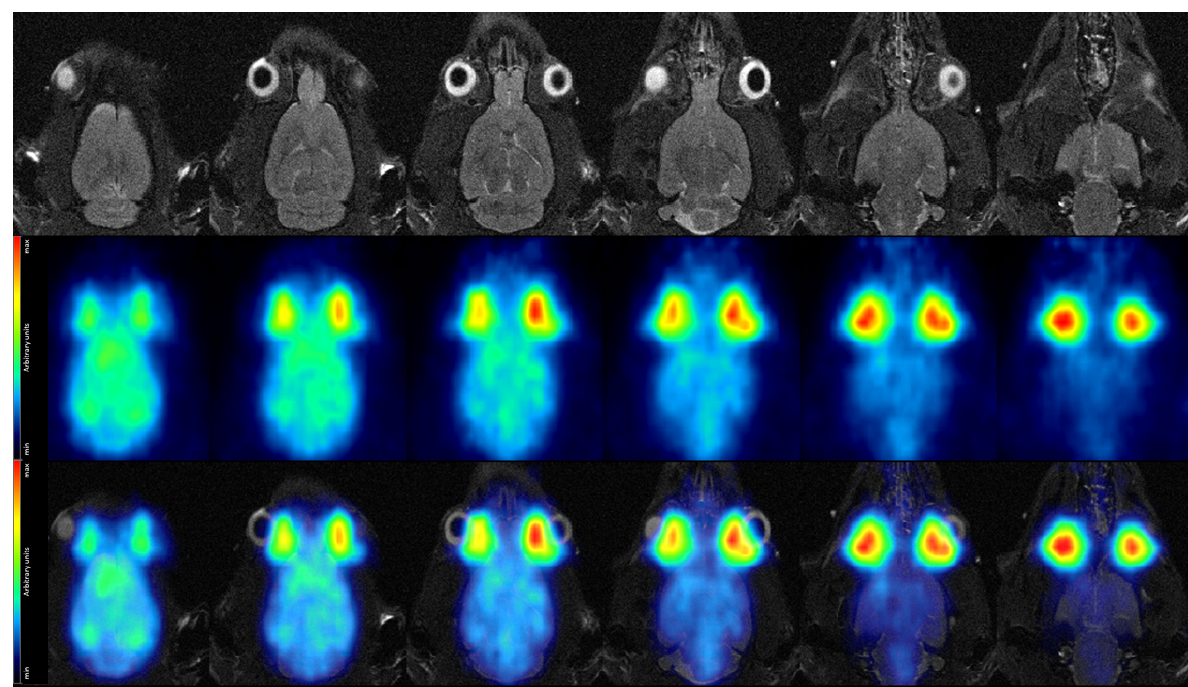
Figure 15. Coronal view of the rat brain in vivo. ( Top row ): MR images acquired with a T2-TurboRARE sequence. ( Middle row ): PET data acquired at high decay rate in a single 5s time frame, recorded 44min after tracer injection. ( Bottom row ): Fused MRI and high-rate PET